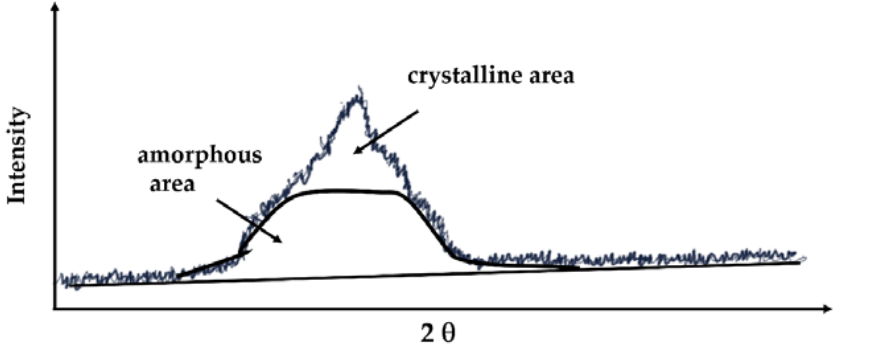
Figure 18. X-ray diffraction patterns of starch films emphasizing the amorphous and crystalline area. Antioxidant and Antimicrobial Activity